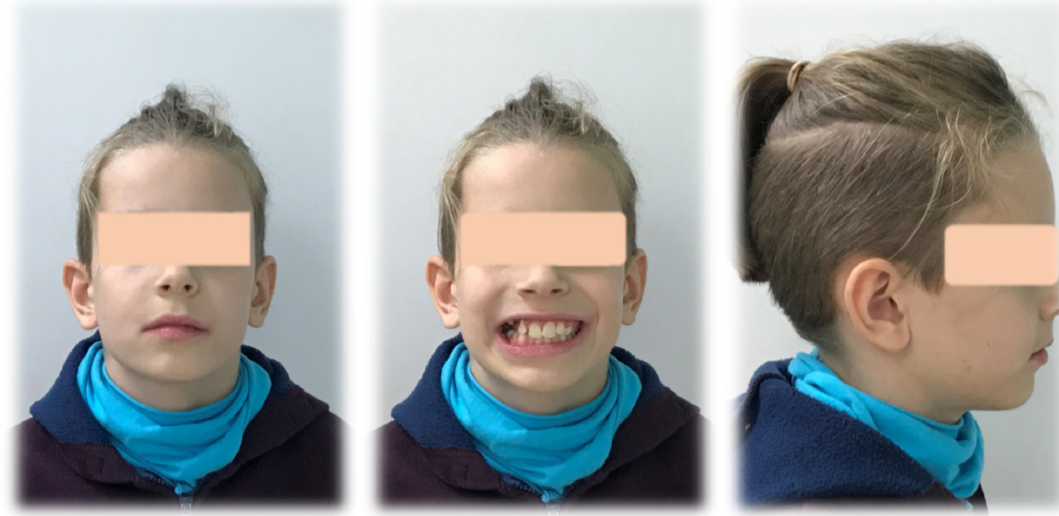
Figure 1. Extraoral photographs before treatment.